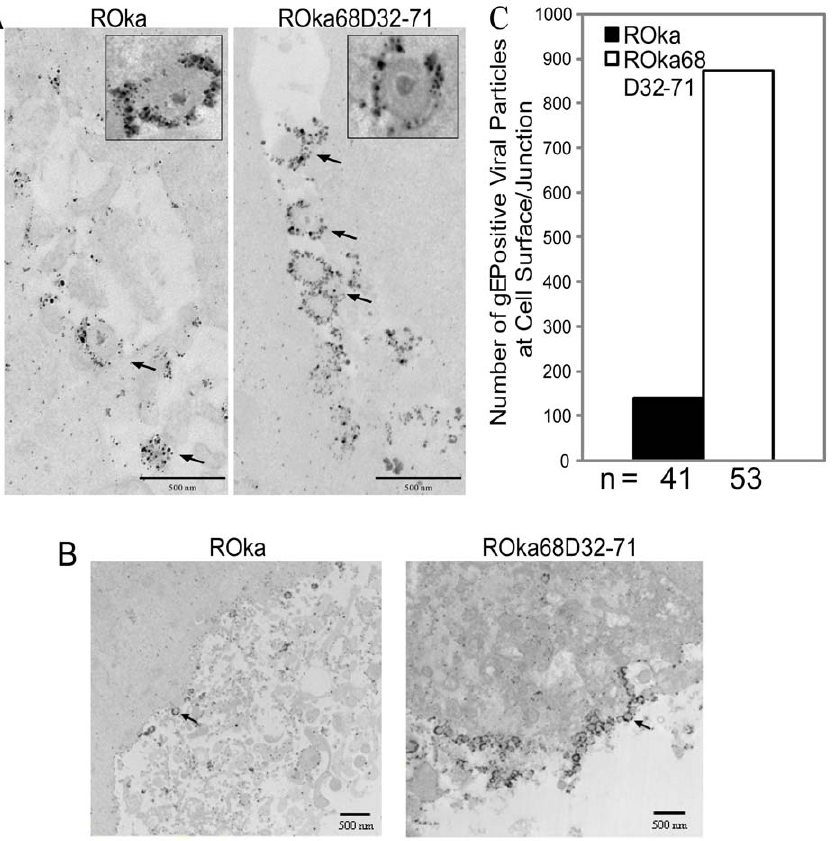
Figure 9. Accumulation of a VZV mutant deleted for the IDE binding domain of gE at the cell surface and at the cell-cell junction. Melanoma cells were infected with VZV ROka or ROka68D32-71, fixed, and incubated with monoclonal antibody to VZV gE followed by FluoroNanogold-conjugated anti-mouse antibody and visualized by transmission electron microscopy. (A) Representative virions at cell-cell junctions are indicated with arrows. Magnification 12000 6 . The insets in panel A provide higher-power images of selected virions. (B) Representative virions on the cell surface are indicated with arrows. Magnification 5000 6 . (C) Quantification of gE-positive virions on the cell surface and at cell-cell junctions. Multiple cells from the experiment in panel A were coded and observed under a Hitachi H7500 transmission electron microscope. gE positive viral particles at cell surface and/or junctions were counted.